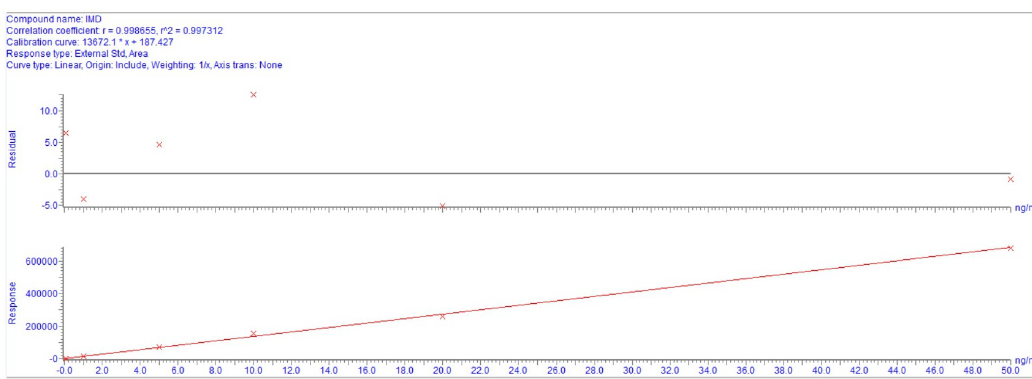
Table 1. The average recovery, intra RSD and inter RSD of IMD in cattle plasma at 3 spiked concentrations. Spiked Concentration (ng/mL) Average Recovery (%) SD (%) Intra RSD (%) Inter RSD (%) 0.2